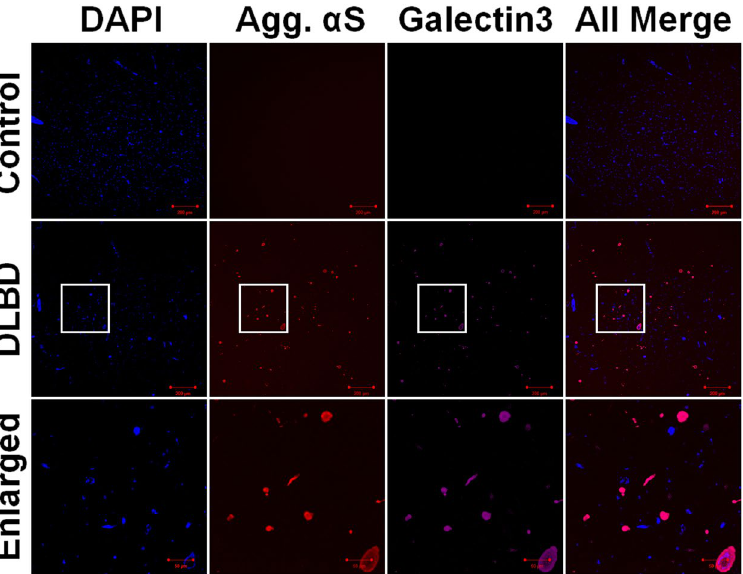
Figure 9. Galectin-3 co-localizes with α S pathology in Lewy body disease. Human specimens containing basal nucleus of Meynert from four patients with DLBD and four age matched controls were evaluated with double- labeling immunofluorescence and antibodies to α S and Galectin-3. The framed areas in the second row (DLBD) are enlarged and shown in the third row (Enlarged). Scale bar: 200 µ m.